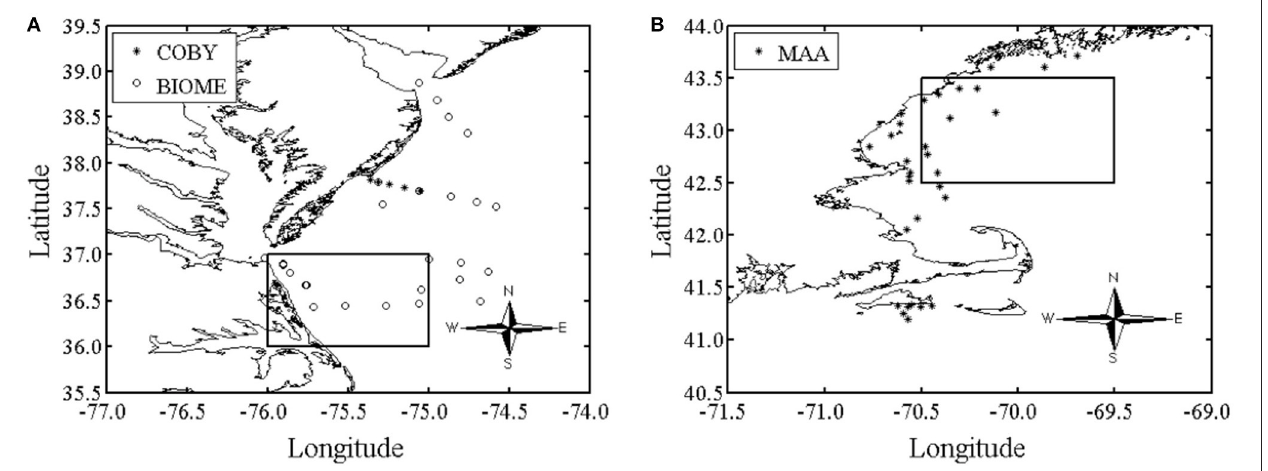
FIGURE 1 | The oceanographic study region was located in: (A) the Delaware, Maryland and Virginia (Delmarva) coastal waters [BIOME and COBY (Bio-physical Interactions in Ocean Margin Ecosystems and Coastal Ocean Buoy Transect), N = 82 samples] during all seasons in 2006 and 2007 and. The square is the area averaged over to represent BIOME in Figure 10 . (B) The coastal waters within the Gulf of Maine and near Martha’s Vineyard (MAA (Mycosporine-like amino acid), N = 90 samples) during spring of 2007. The data set includes all seasons for the Delmarva region in 2006 and 2007 and only spring samples from the Gulf of Maine in 2007. Both sample regions are along the eastern coast of the United States. The square is the area averaged over to represent MAA in Figure 10 .